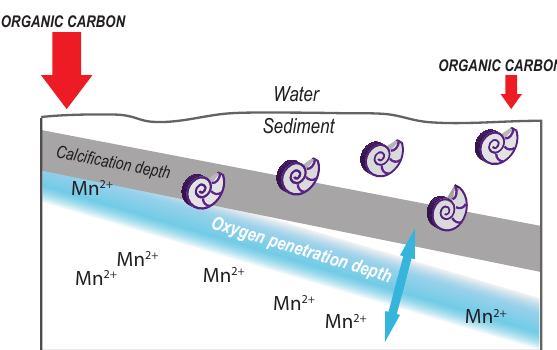
Figure 8. Schematic diagram of a shallow infaunal and intermediate infaunal benthic foraminifera and their spatial relationship with the sediment redox boundaries, migration zone, ALD, and calcification